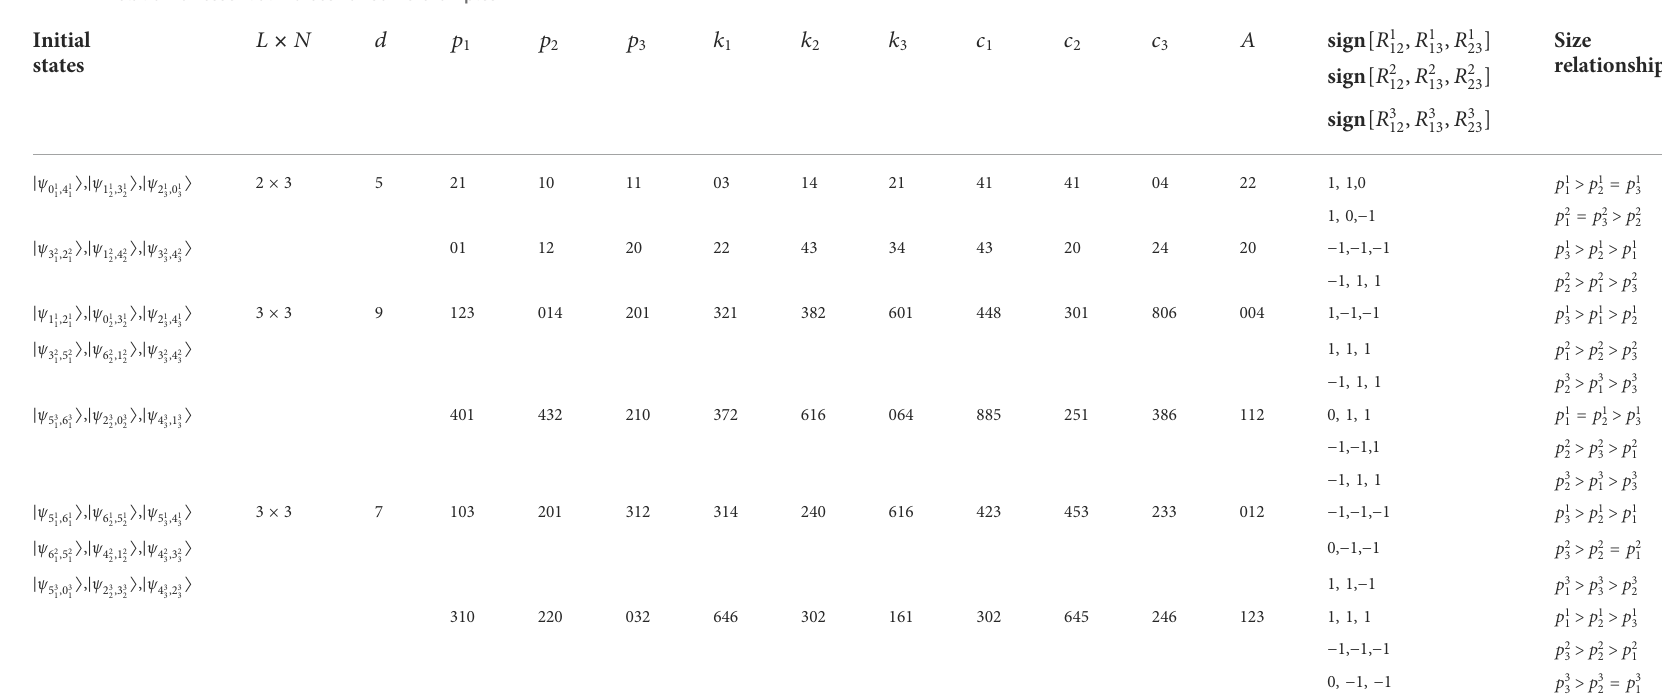
TABLE 1 Relation of essential indices for some